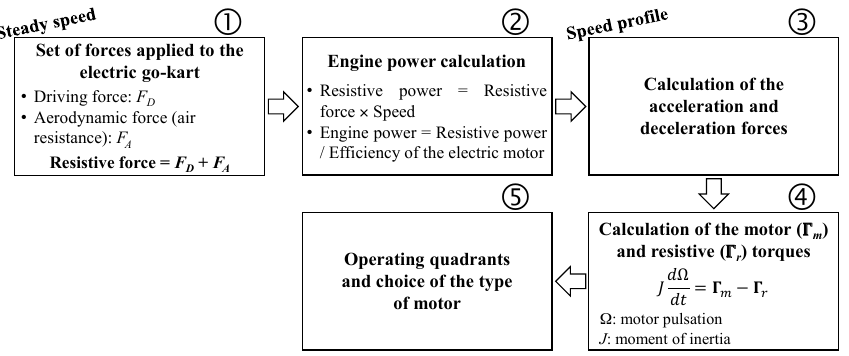
Fig. 1. Five main steps necessary to size the electric